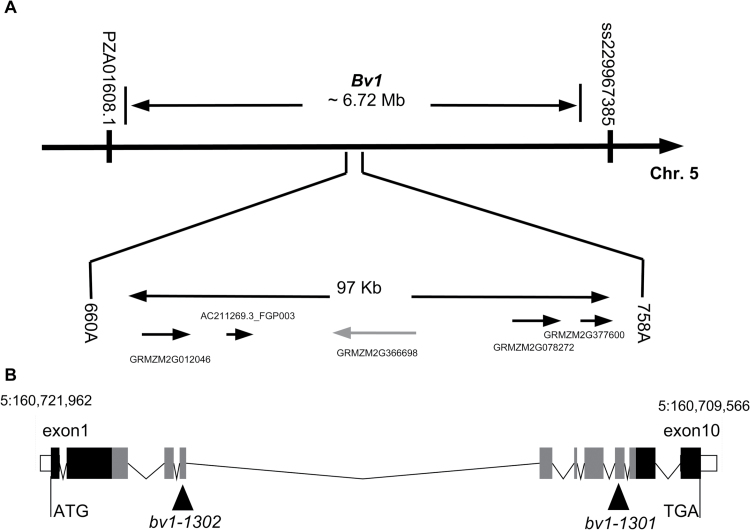
(A) The bv1 locus genetically maps between SNP markers PZA01608.1 and ss229967385 with physical positions 158 599 491 and 165 319 744, respectively, on chromosome 5. Fine mapping of bv1 to an ~97kb region using SNP markers 660A and 758A with physical positions 160 660 813 and 160 758 241 (based on markers ss229964467 and ss229964577 from the HapMap project; Gore et al., 2009). The arrows represent the genes and their transcription orientation for this region, according to the B73 genome (AGPv2 release 5b.60). In grey is the candidate gene GRMZM2G366698. (B) Exons (solid boxes) and introns (lines) of transcript GRMZM2G366698_T01. The inositol phosphatase domain is shown in grey spanning from exon 2 to exon 9 (IPPc pfam PF03372, aa 249–595). White boxes are untranslated regions. Mutation points in bv1-1301 and bv1-1302 alleles are shown with arrowheads.